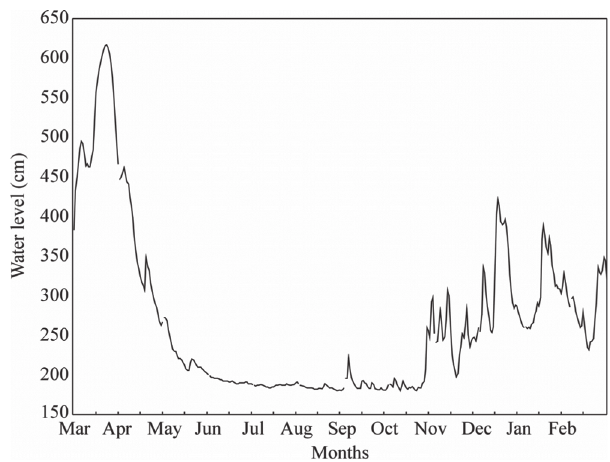
Fig. 2. Relative water levels in the study area, Cuiabá River and Chacororé Lake, State of Mato Grosso, Brazil, from March 2000 to February 2001, showing the rainy and dry seasons. The data were provided by the Agência Nacional de Águas